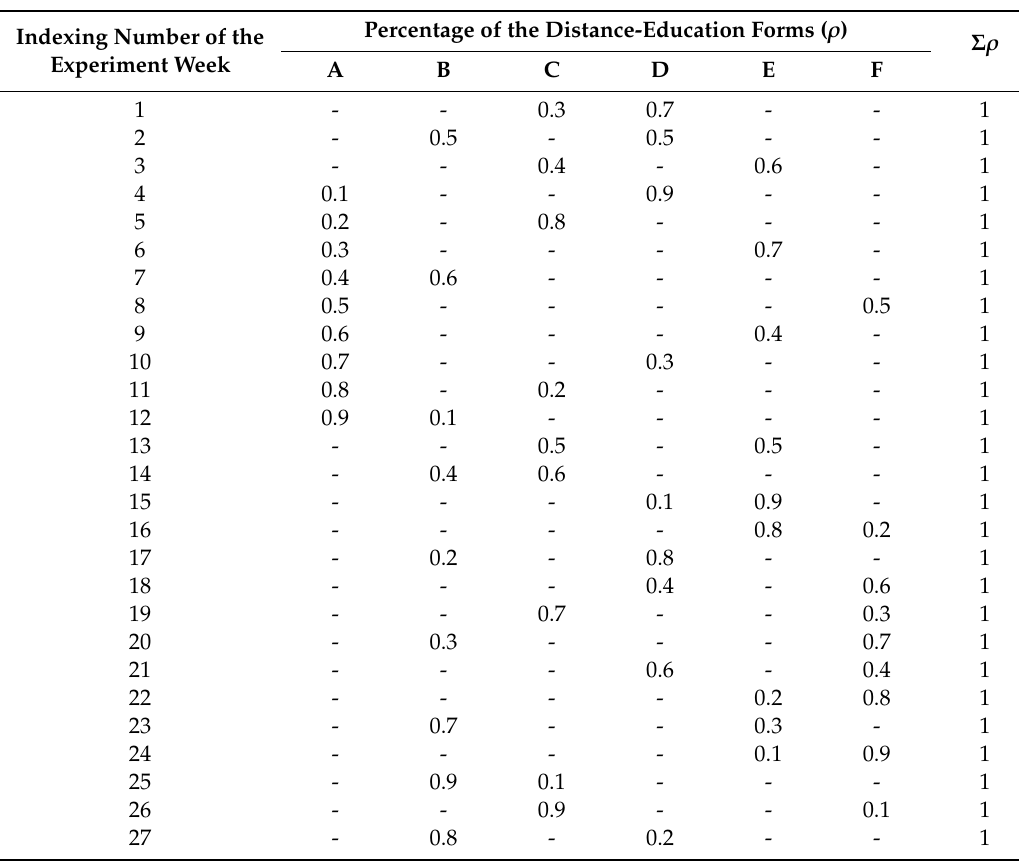
Table A3. Schedule for conducting an experiment to improve the distance-learning e ff ectiveness at the university: a case study of learning the discipline “Protection and Automation of Electrical Power Systems”.